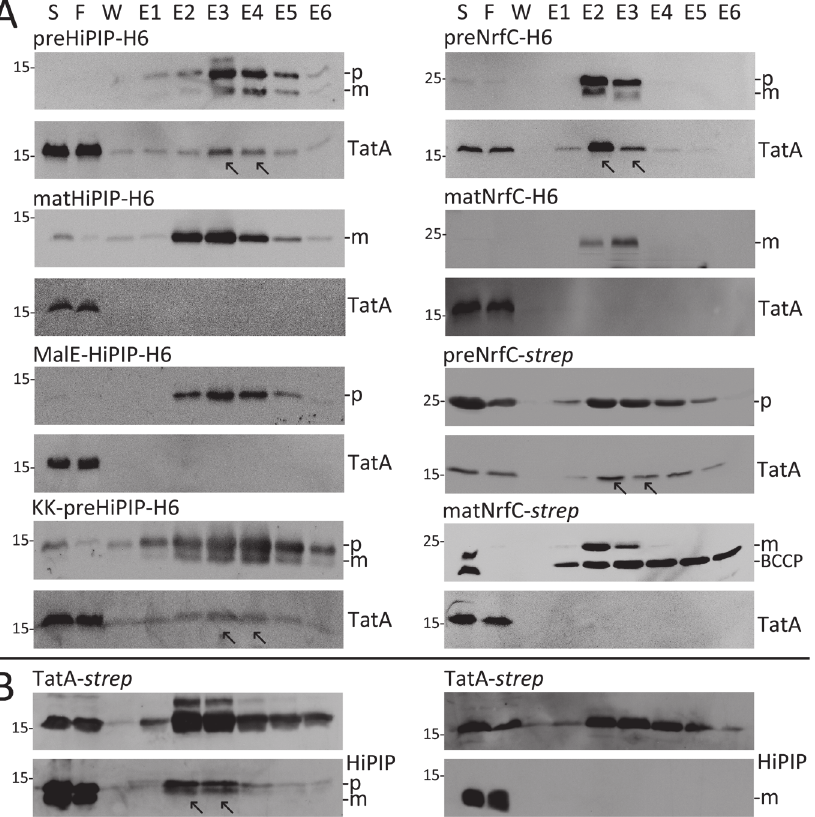
Fig 7. TatA/Tat substrate interactions in solution. (A) Soluble non-recombinant TatA co-purifies with the precursor of HiPIP and NrfC and not with their mature forms. Precursor and mature forms of HiPIP were produced in E . coli strain MC4100 using pEXH5 tac -H6 and pEXH5 tac -mat-H6, respectively. The MalE-signal peptide-HiPIP fusion protein was produced using pEXH5 tac - malE (sp)-H6, and the RR > KK mutated HiPIP variant was produced using pEXH5 tac -H6-KK. Precursor and mature forms of NrfC were produced using pBW- nrfC -H6, pBW- nrfC -mat-H6, pBW- nrfC - strep or pBW- nrfC -mat- strep , as indicated. Soluble protein (S), flow-through (F), wash (W) and elution fractions (E1-6) were analyzed by SDS-PAGE Western blotting, using antibodies directed against HiPIP, the H6-Tag (in case of NrfC), or TatA as indicated. (B) In vitro folded pure HiPIP precursor associates with tagged soluble TatA. 5 μ M of precursor (left panel) or mature (right panel) HiPIP were added to crude soluble extracts containing wild-type level TatA- strep (from strain DADE tatA- strep-tatBC ), incubated at room temperature for 20 min and used for affinity chromatography. Further analyses were carried out as in A), using antibodies directed against TatA or HiPIP, as indicated. Arrows in A) and B) indicate co-elutions. p, precursor; m, mature form; BCCP, biotin carboxyl carrier